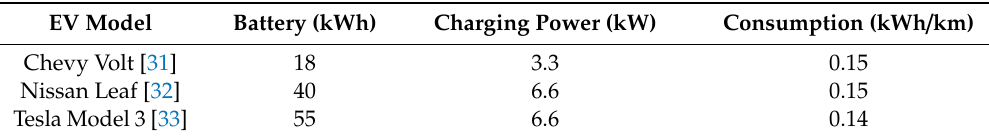
Table 1. EV model and specifications.